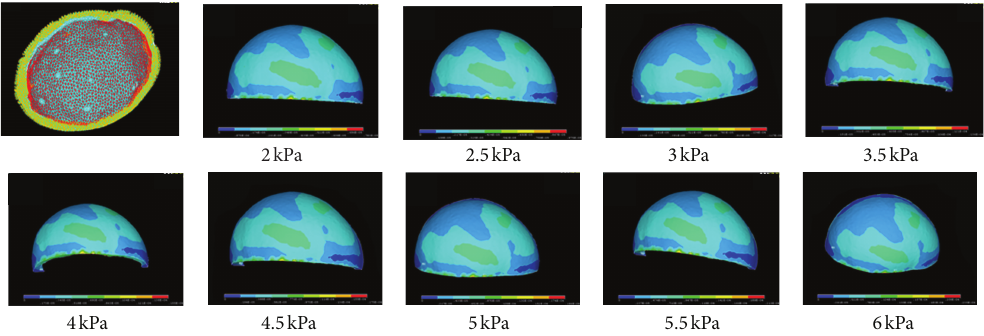
Figure 25: Analysis of cranial cavity with Prony model.